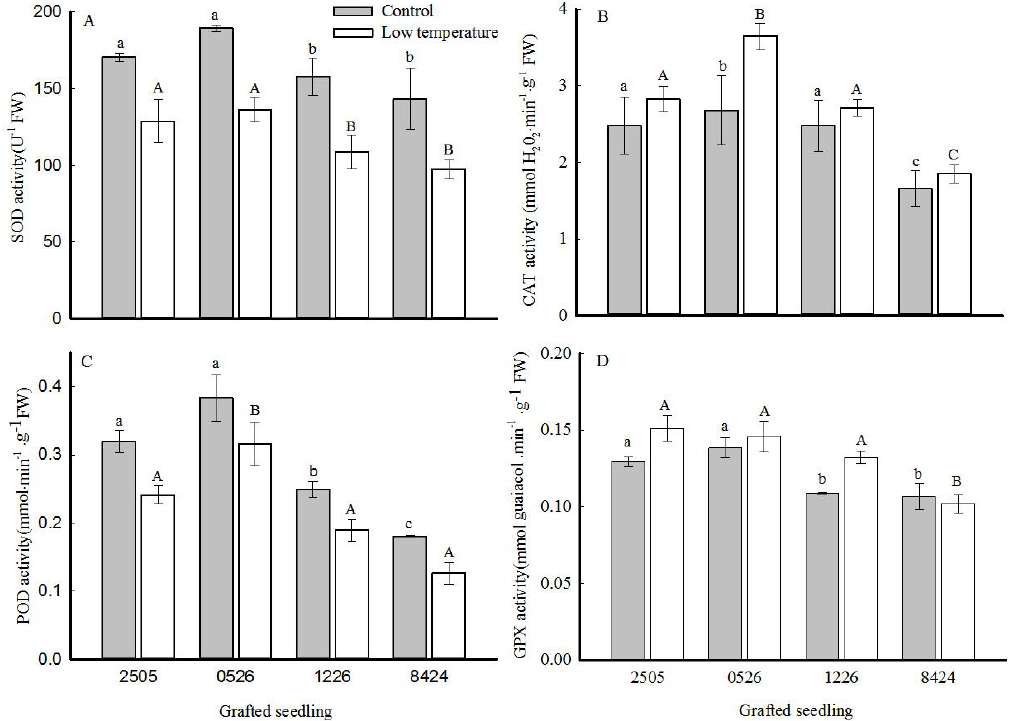
Figure 3. Effect of low temperature on activities of SOD, CAT, POD, and GPX ( A – D ) in leaves of different grafted seedlings. Data are the mean ± SE. Bars with different letters indicate a significant difference (p < 0.05).